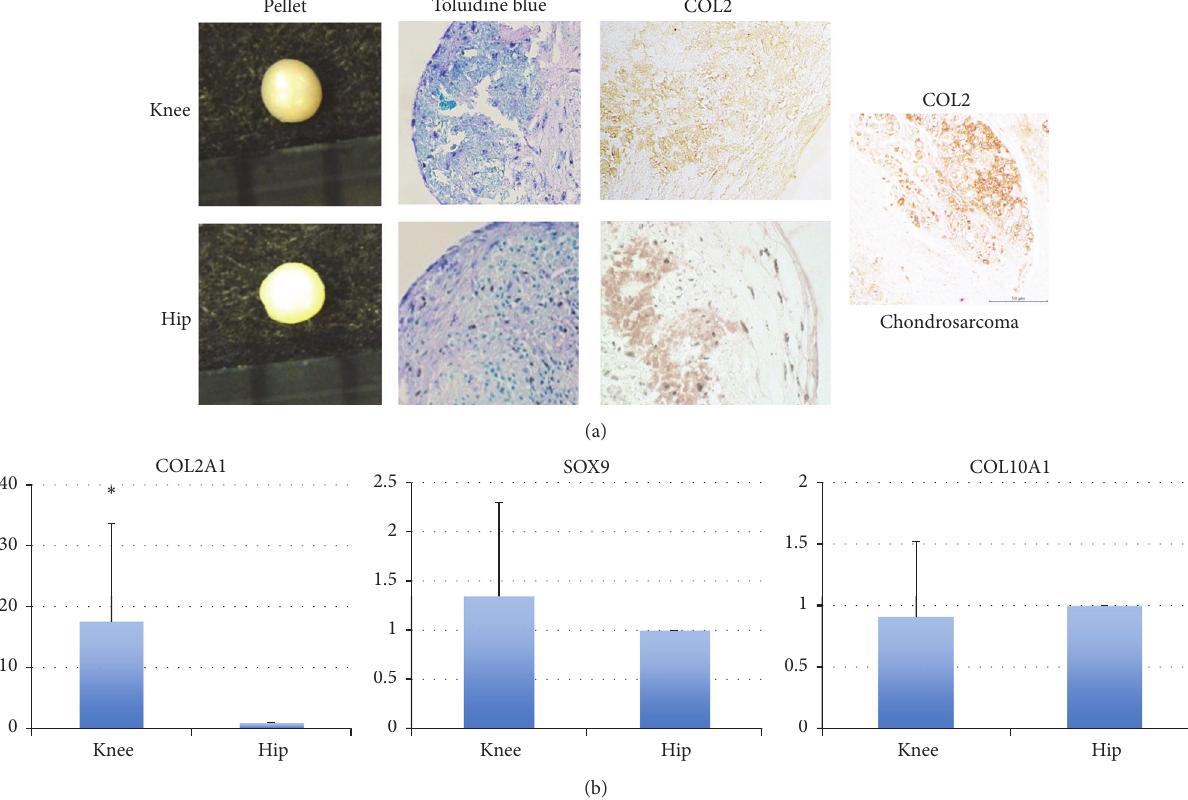
Figure 7: Chondrogenic potential of each type of synovial cell. (a) The pellets from each sample were shown. There was no significant difference in the diameter of pellets between knee and hip ( 𝑃 = 0.82 , Mann–Whitney 𝑈 test). Histological analysis was performed on tissues stained with Toluidine Blue staining and immunocytochemical analysis with type II collagen by tissue source and human chondrosarcoma for positive control. (b) Real-time RT-PCR. The bar means standard deviation. Expression of COL2 gene in knee was significantly higher than that in hip ( 𝑃 < 0.05 , Mann–Whitney U test). ∗ Significant